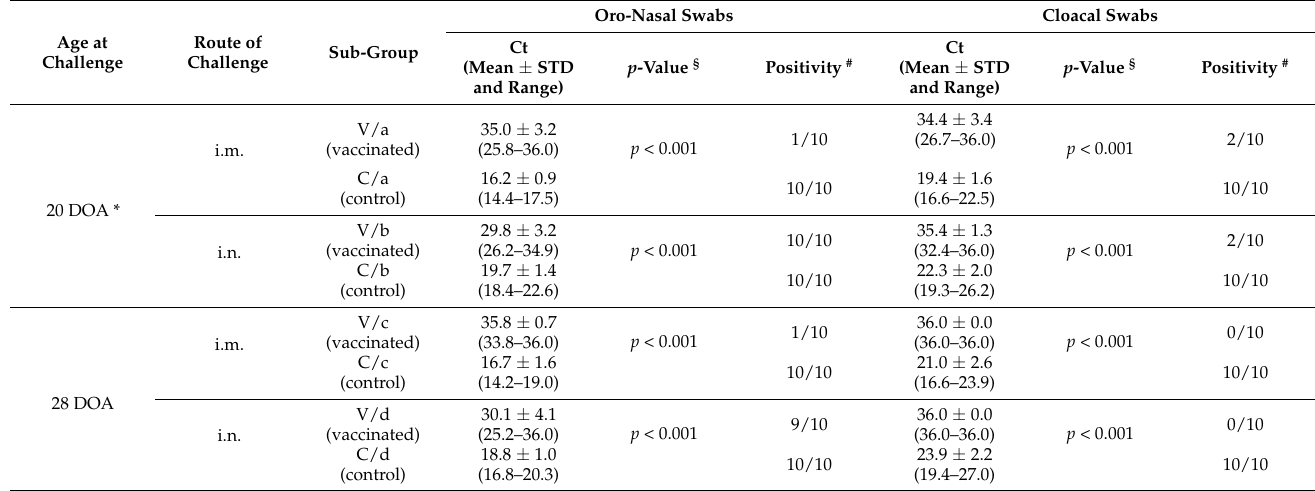
Table 4. Challenge virus shedding (measured with one-step RT-real-time